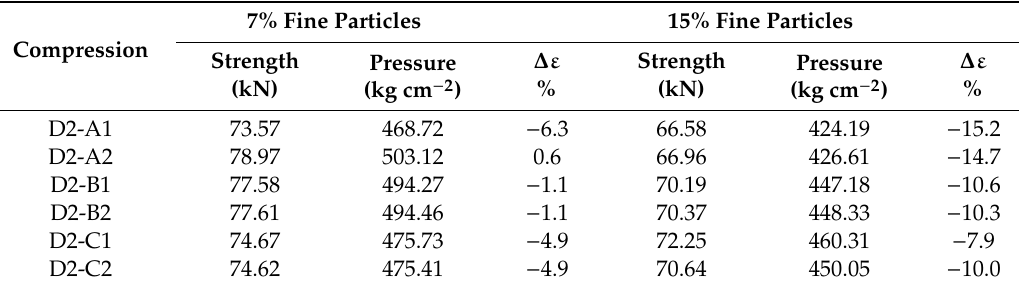
Table 9. Compression assay results for 7% and 15% fine